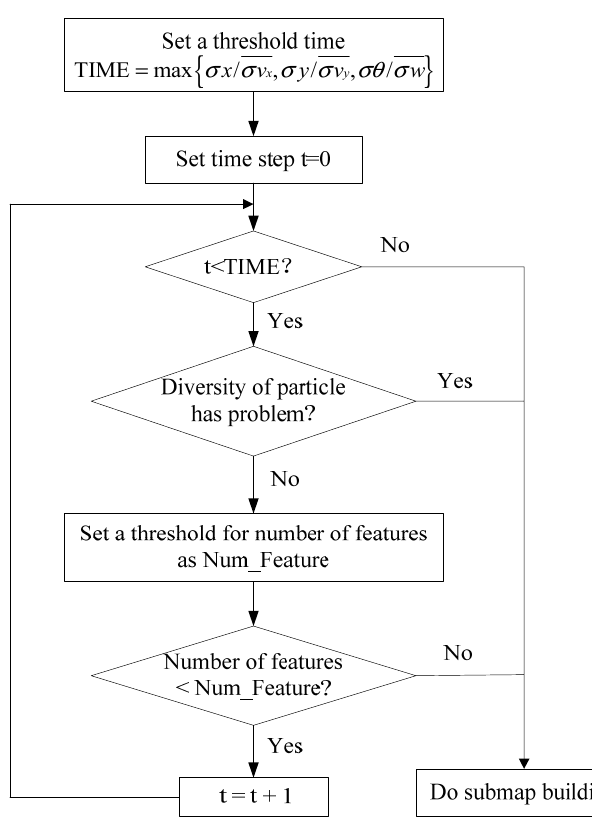
Figure 2. Decision-making Strategy.